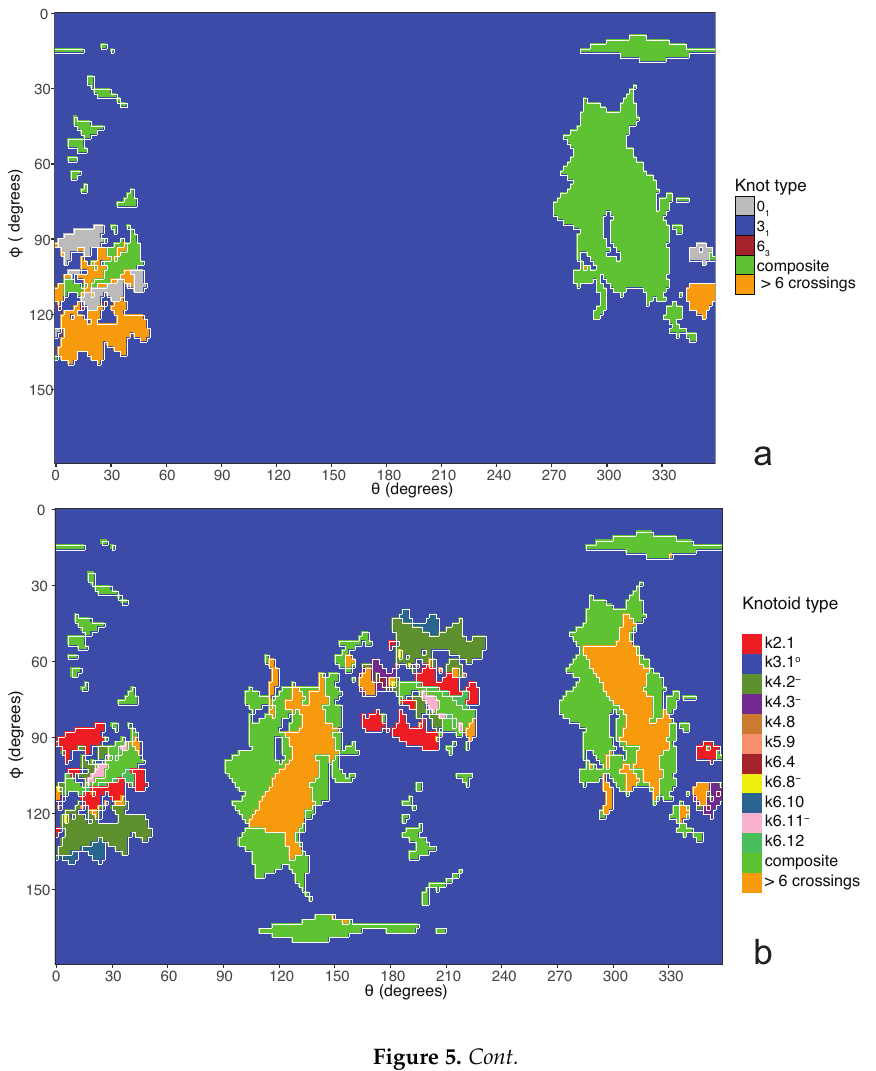
Figure 4. The projection globes for ( a ) the uniform closure technique; ( b ) the spherical knotoids technique; and ( c ) the planar knotoids technique.